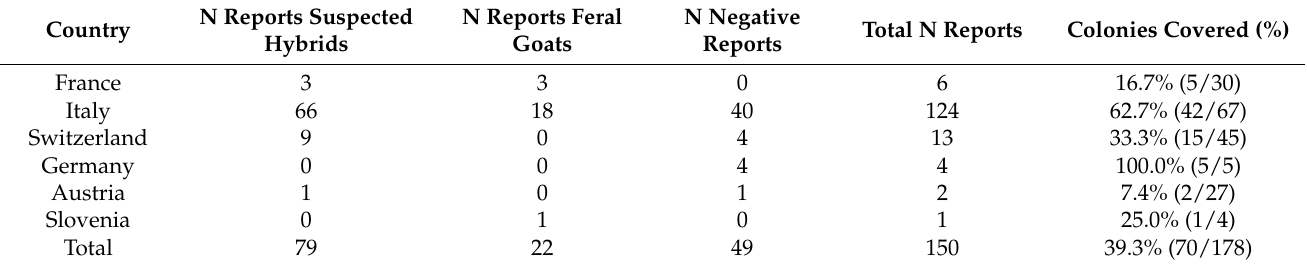
Table 1. Summary table of the geographic origin of the reports gathered during the study and % of the colonies covered by the study. For each country, the % of colonies covered was calculated as the ratio between the colonies for which either a report of suspected hybrids or a negative report were received and the total number of Alpine ibex colonies of that country. The total number of colonies per country was obtained from [32]. The number of reports does not correspond to the number of colonies covered as some reports covered more than one colony, while other colonies were covered by more than one report from different